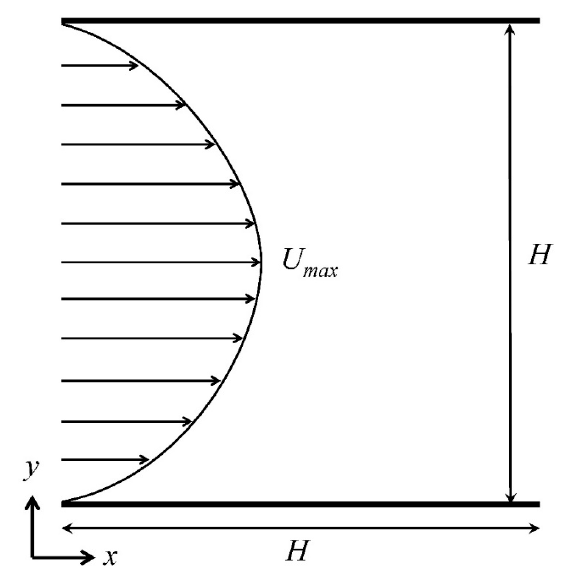
Figure 5. Schematic of single-phase Poiseuille flow in 2D.